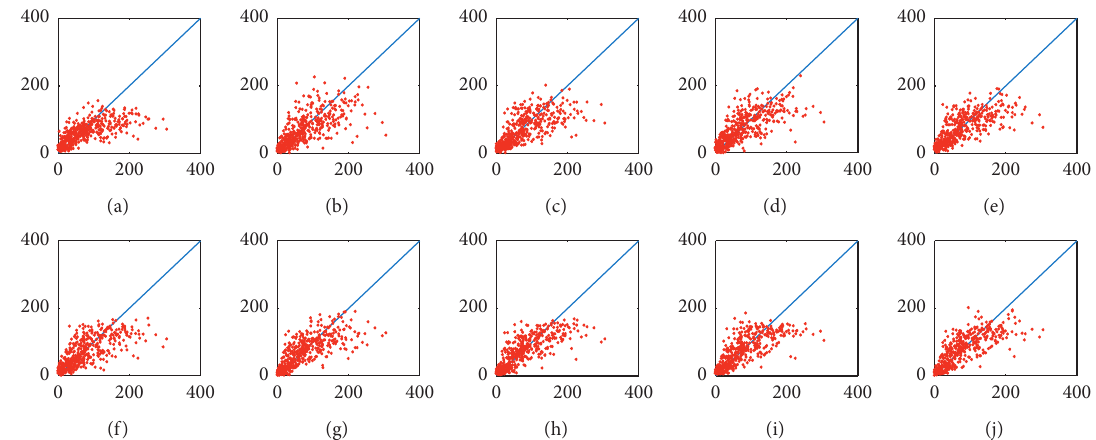
Figure 10: Scatter plots between downscaled results and observed precipitation in the period of 1961–2005 for SVR. Horizontal axes show observed precipitation, and vertical axes show the SVR results. (a) AC10, (b) AC13, (c) GG, (d) GH, (e) GM, (f) GR, (g) IN, (h) Nor, (i) MME, (j)